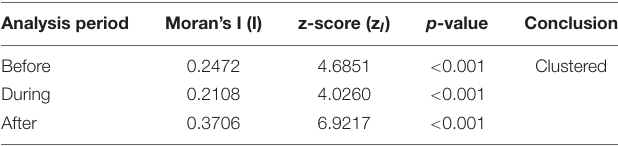
TABLE 4 | Global analysis results by analysis period for 2017, including Moran’s I value (I), the z-score (z I ), and the associated p -value. Analysis